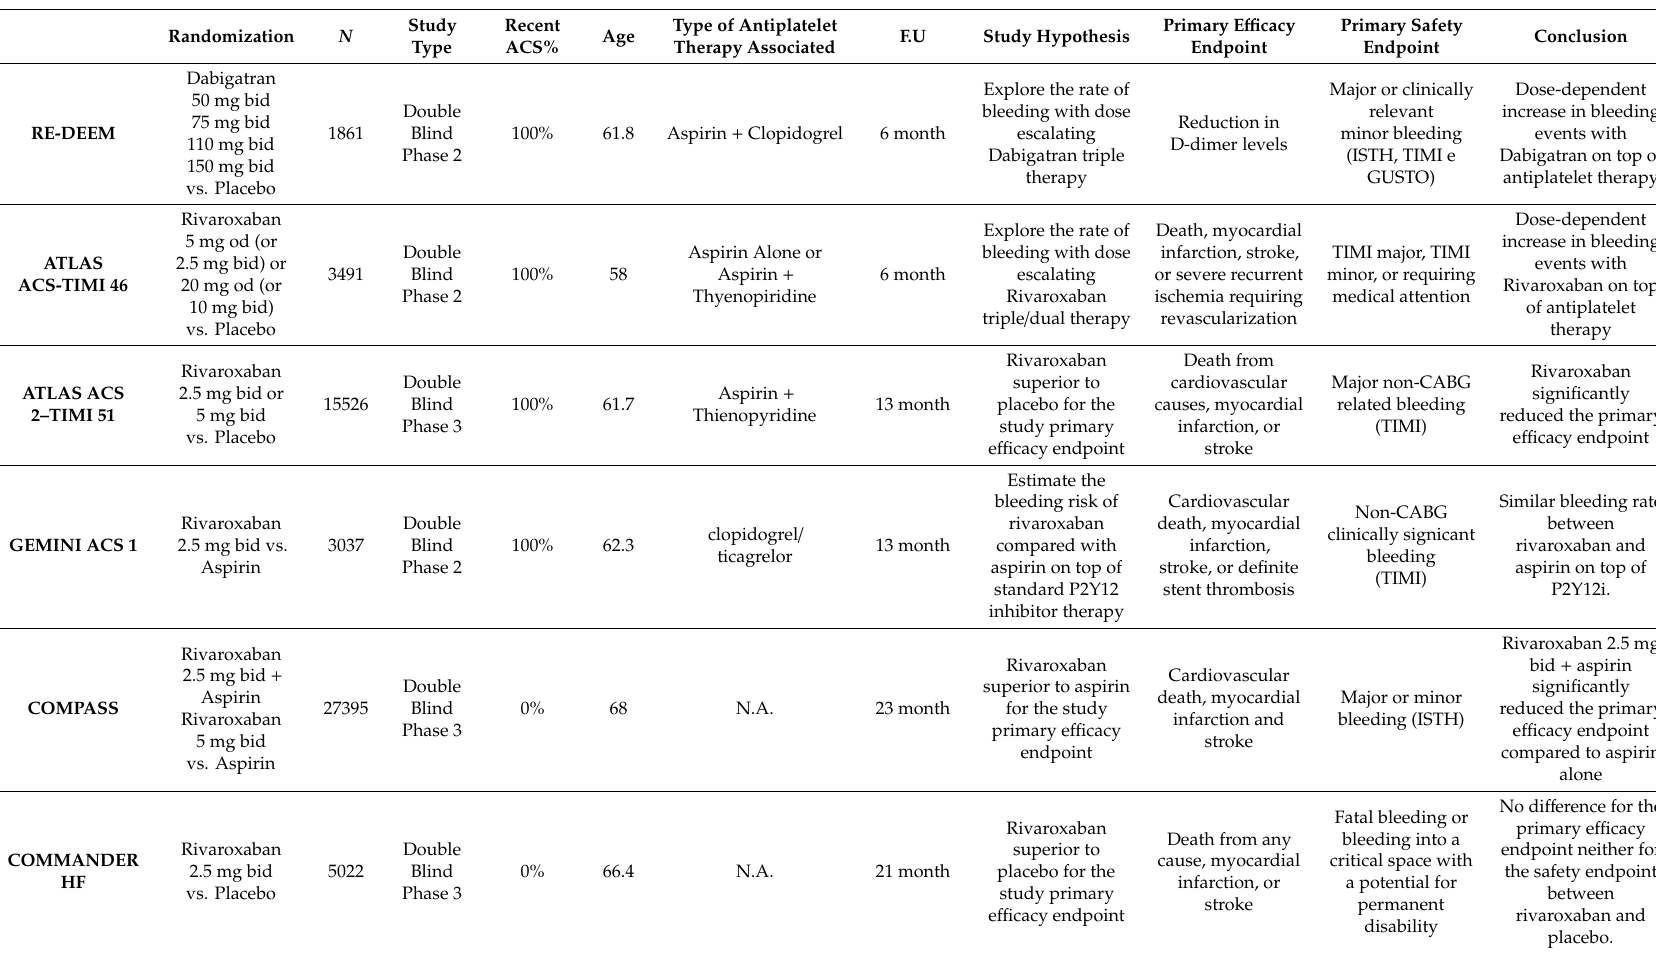
Table 2. Randomized controlled trials evaluating the e ff ect of commercially available direct oral anticoagulants in patients with coronary artery